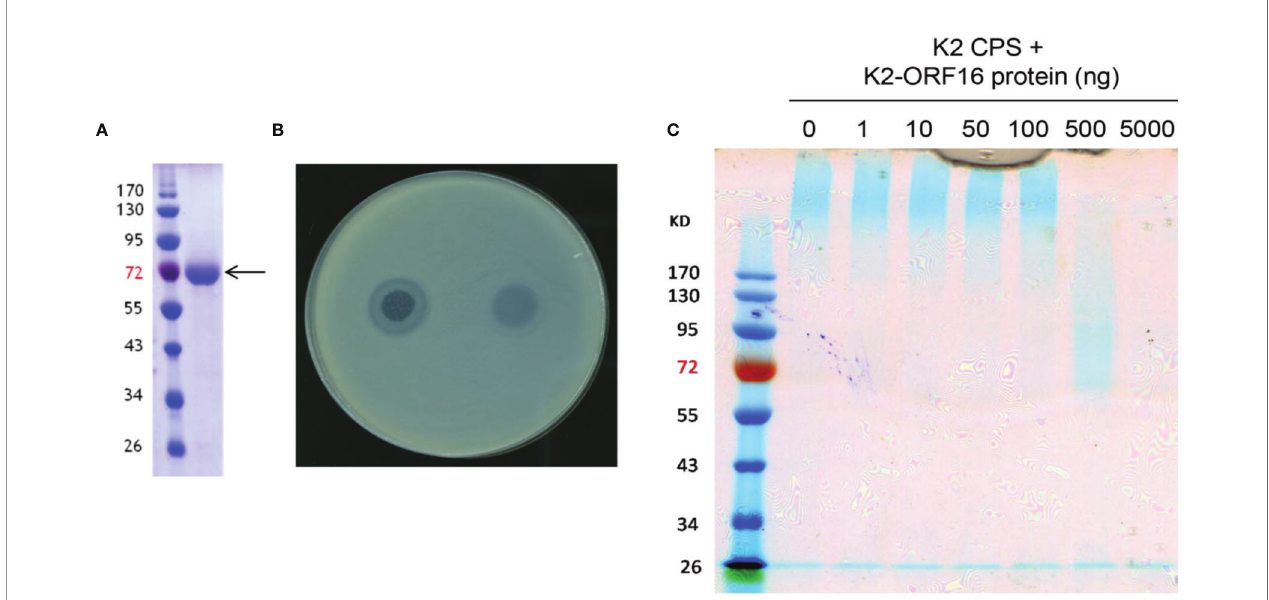
FIGURE 2 | The enzymatic activity of puri fi ed K2-ORF16 protein. (A) The puri fi ed K2-ORF16 protein (right column; indicated with the arrow) was subjected to SDS- PAGE and stained with Coomassie brilliant blue; the sizes (in kDa) of protein marker bands are indicated next to the left column. (B) A clear spot surrounded by a translucent halo (left) and a translucent spot (right) were observed when the phage 1611E-K2-1 and puri fi ed K2-ORF16 protein (respectively) were spotted on a plate overlaid with top agar containing the K pneumoniae 1611E strain. (C) Extracted K2 CPS was treated with various amounts (0-5000 ng) of K2-ORF16 protein and subjected to SDS-PAGE followed by staining with Alcian blue. Left-most column contains protein markers (with sizes in kDa indicated to the